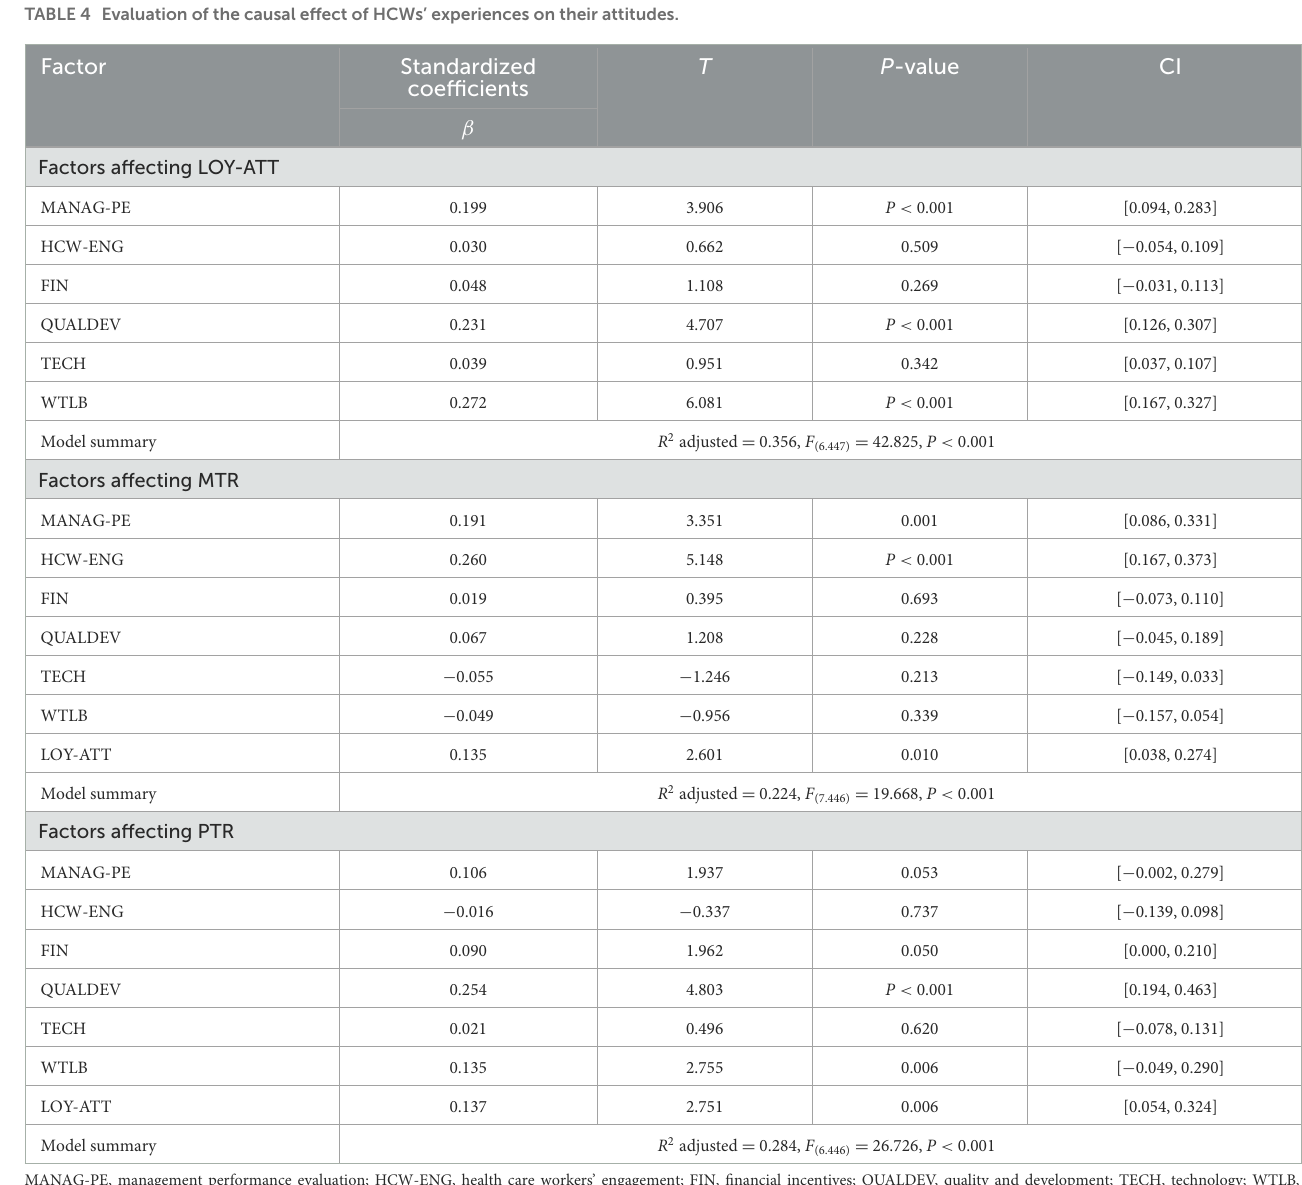
TABLE 4 Evaluation of the causal effect of HCWs’ experiences on their